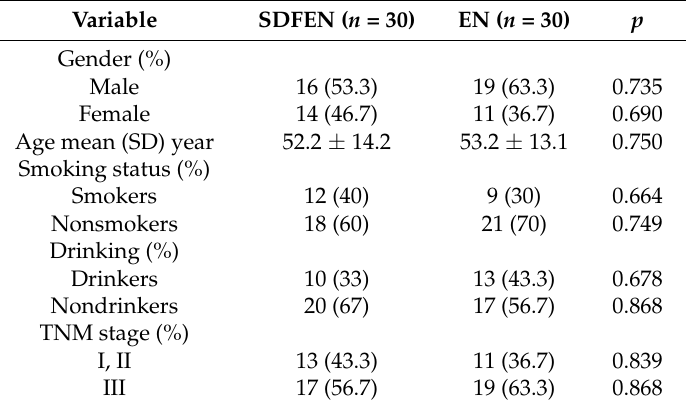
Table 2. Characteristics of the cases and control.